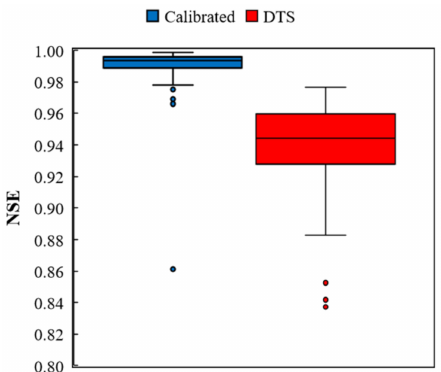
Figure 11. Nash–Sutcliffe Efficiency Index for calibrated and DTS